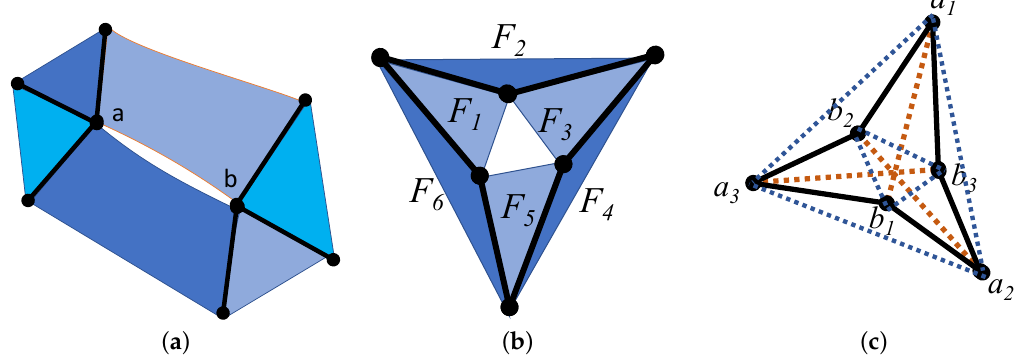
Figure 65. Cycles of 6 faces for C 1 -splines. ( a ) is generically dependent. ( b ) is a subset of an octahedral graph which is 2 generically independent. ( c ) is a special projective condition for dependence of the octahedral graph of the Morgan–Scott split decomposition of the exterior triangle and therefore of the cycle. The first two parts are spline analogues in the plane of the body–hinge frameworks in Figure